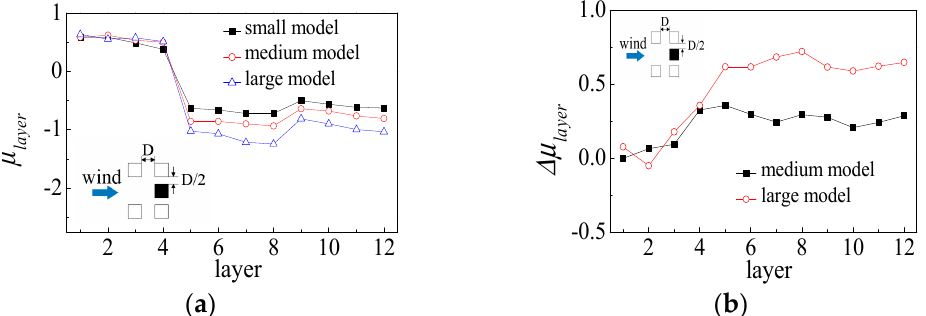
Figure 9. The wind tunnel test results of test condition 2. ( a ) Layer pressure coefficient; ( b ) relative error of layer pressure coefficient.